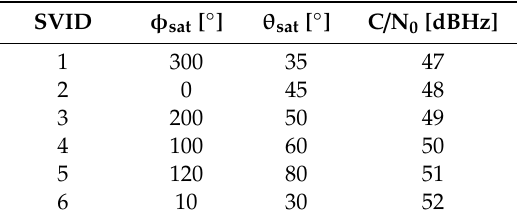
Table 3. Parameters of simulated genuine GPS